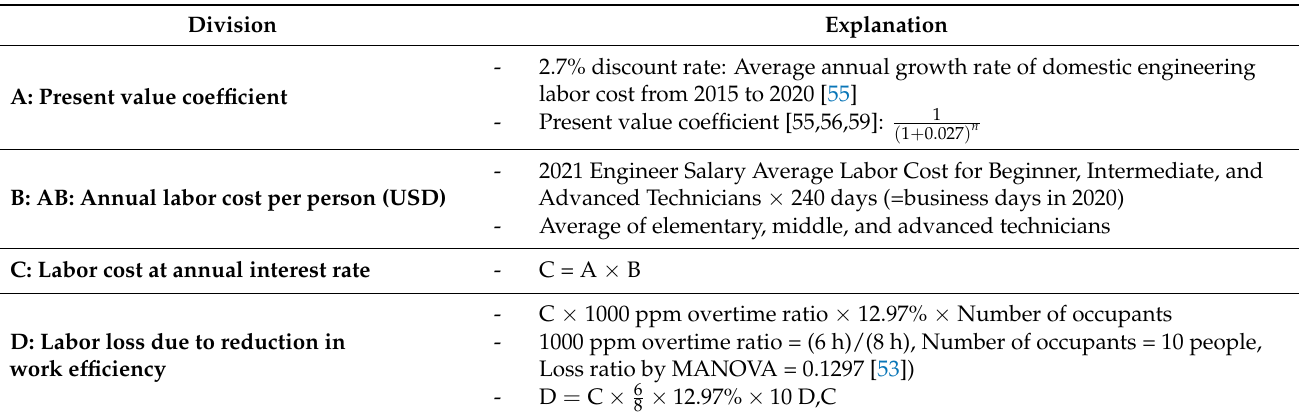
Table 3. Decrease in work efficiency by applying the present value coefficient to 10 people (currency: